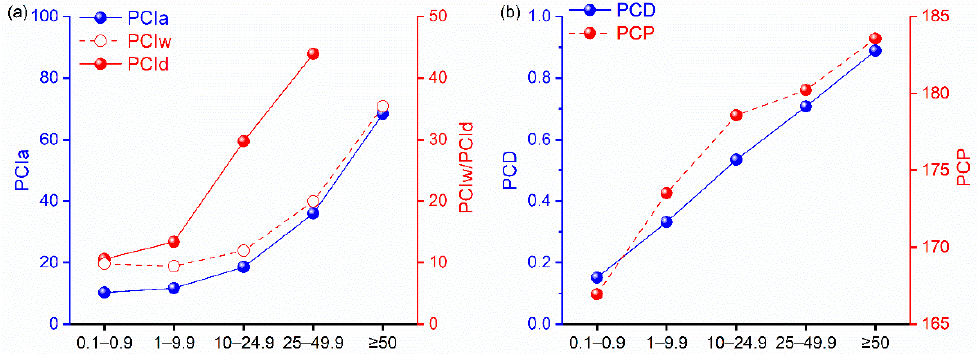
Figure 4. The annual averages of the ( a ) PCI and ( b ) PCD and PCP at each intensity over the basin. PCIa is the precipitation concentration index value on an annual scale, PCIw is the precipitation concentration index value for the wet season, PCId is the precipitation concentration index value for the dry season, PCD is the precipitation concentration degree value, and PCP is the precipitation concentration period value.